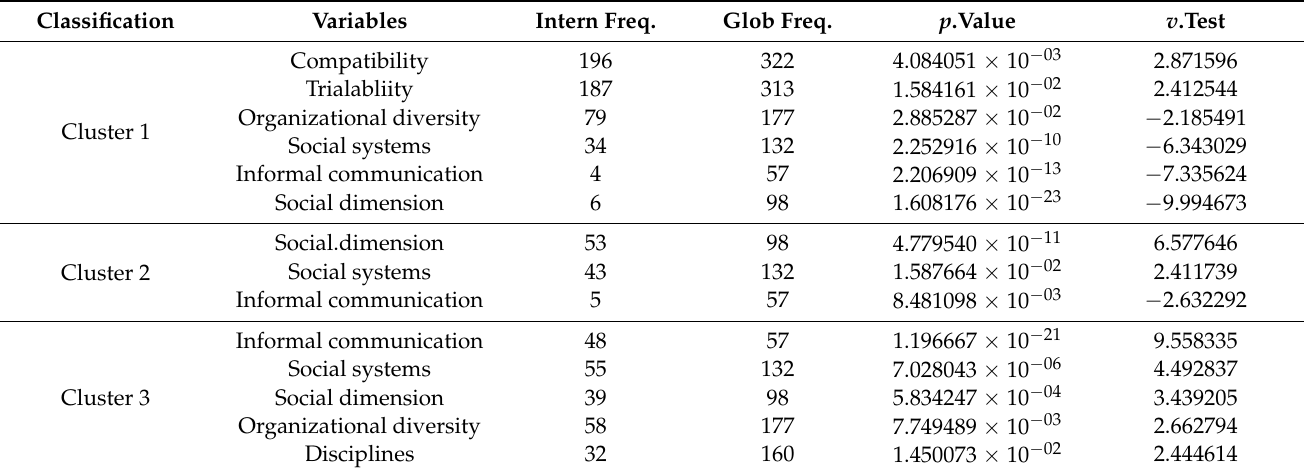
Table 3. Significant variables contributing to three different clusters with their frequencies, p .value, and v